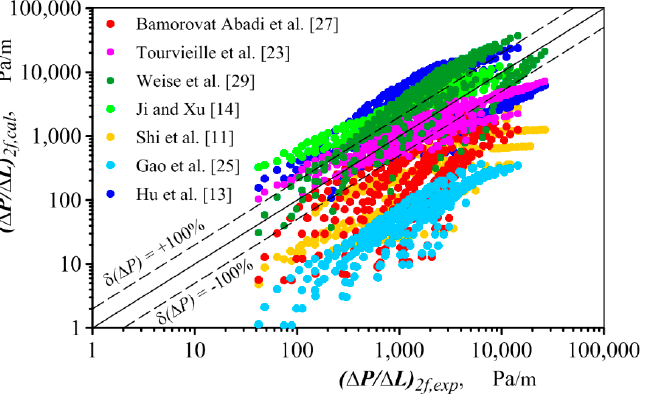
Figure 11. Comparison between measured pressure drops in gas–liquid flow ( Δ P/ Δ L) 2f , sxp and pres- sure drops ( Δ P/ Δ L) 2f , cal calculated from the correlations proposed by references